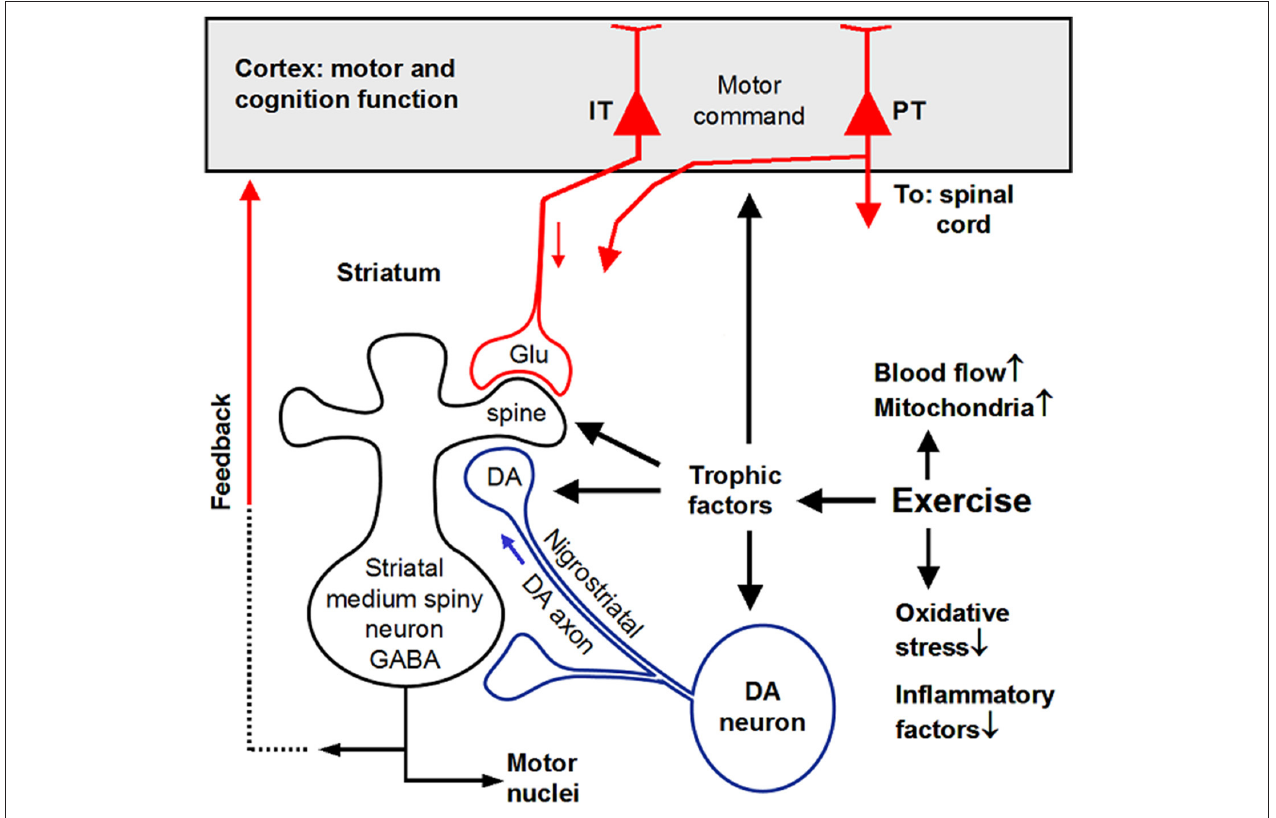
FIGURE 5 | Summary diagram showing that exercise triggers trophic factor production that in turn induce neuroprotection and neurorestoration. IT, intratelencephalically projecting cortical neurons; PT, pyramidal tract projecting cortical neurons. Original artwork of Fu-Ming Zhou.